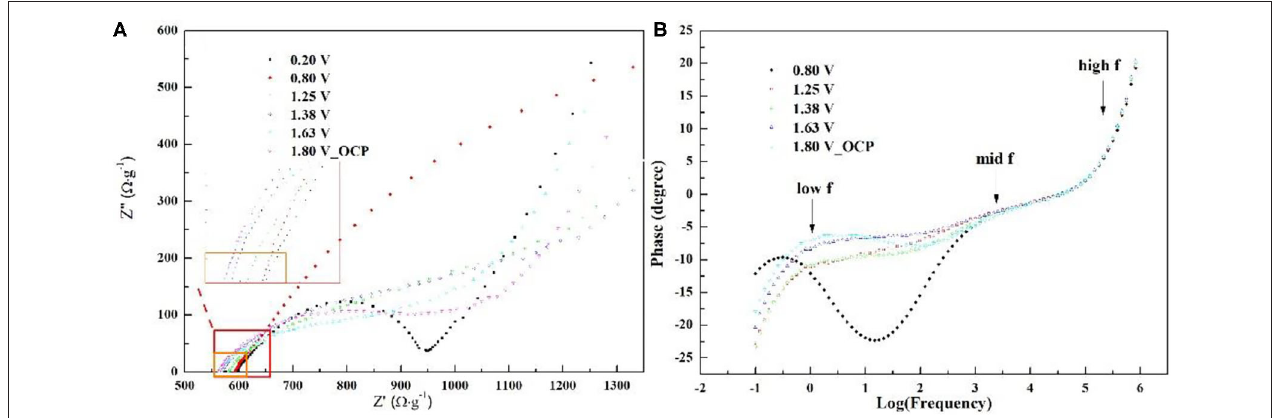
FIGURE 6 | Nyquist plots (A) and Bode plots (B) of the ZIB with S3, Zn foil, and 1M ZnSO 4 in a CR2032 coin under different voltage (the chosen voltage was based on the platform and peak location in CV of